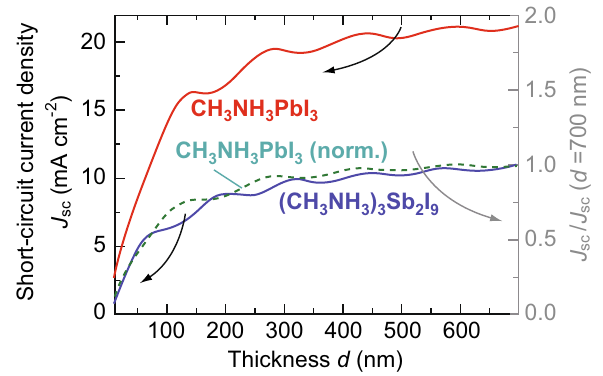
Fig. 25 Plot of the thickness-dependent short-circuit current density J sc of different perovskites. Reproduced with permission Ref. [236]. Copyright (cid:2) 2016 American Chemical Society